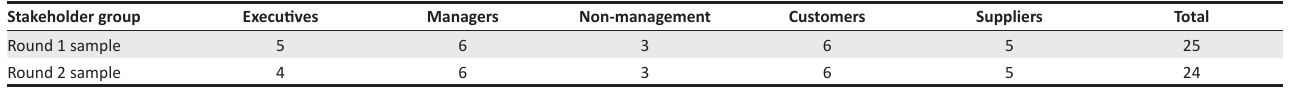
FIGURE 1: Conceptual model of the relationships between perceived leadership attributes, social capital and organisational TABLE 2: Qualitative sample phase 2. Stakeholder group